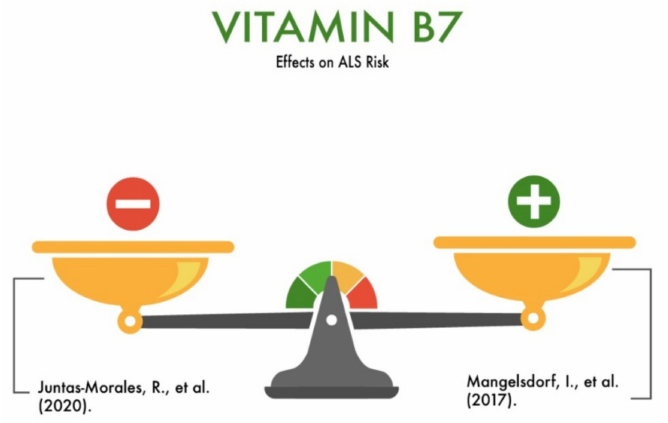
Figure 5. The effect of vitamin B7 on the risk of developing amyotrophic lateral sclerosis